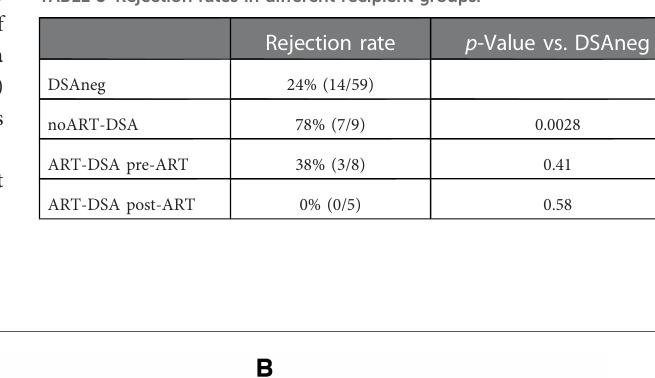
TABLE 3 Rejection rates in different recipient